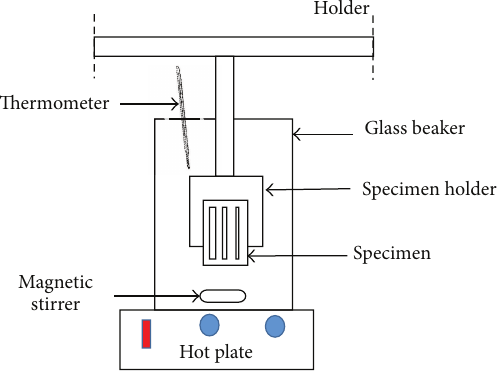
Figure 2: Experimental setup for Monel 400